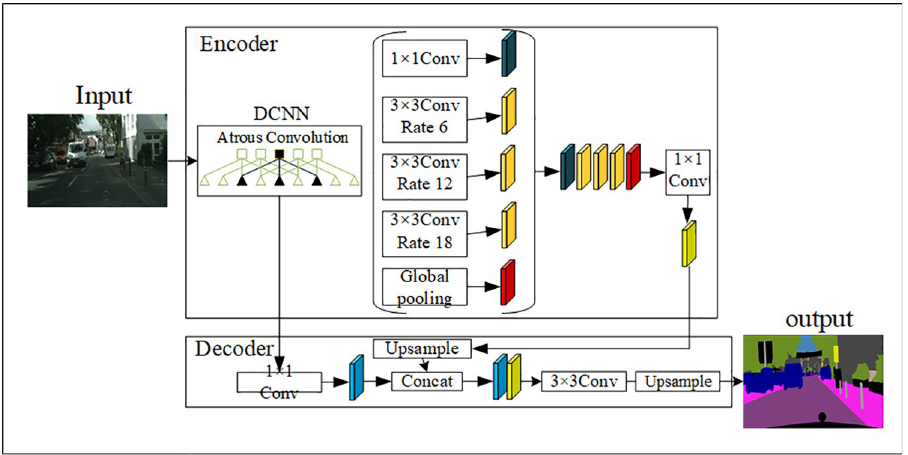
Deeplabv3+ encoding structure is composed of ResNet-101 network and void space pyra- mid module, in which ResNet-101 is mainly divided into 5 parts. The first part is a convolu- tional layer of 7 × 7 × 64, and the other 4 parts contain 3, 4, 23, and 3 blocks respectively. As shown in Fig 3(A), each Block is composed of three convolutional layers plus shortcut connec- tions. The void space pyramid pooling module is connected at the end of the ResNet-101 net- work to obtain the semantic information of multi-scale images. The decoding structure performs 4-fold bilinear up-sampling on the feature map output by the encoder network, and then merges it with the low-level feature information at the channel level to restore the spatial information lost during the downsampling process.